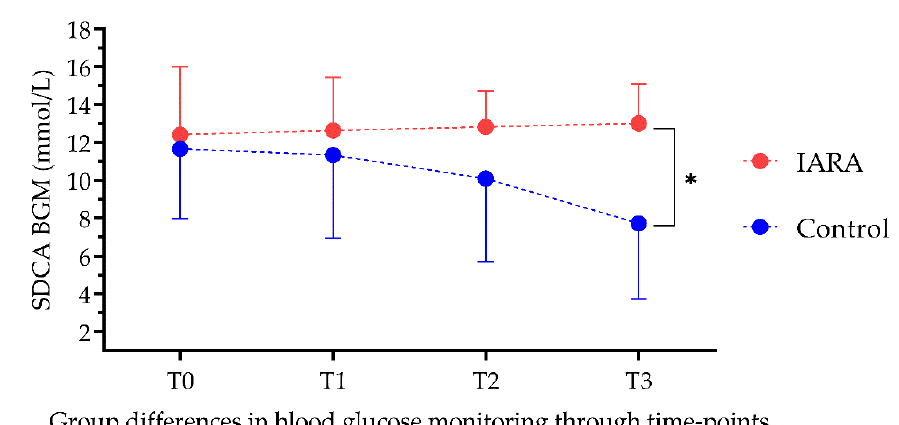
Figure 3. State anxiety was significantly reduced in people who followed the IARA model. STAI- YI — State Anxiety Scale; T0 — baseline; T1 — 3-month follow-up; T2 — 6-month follow-up; T3 — 12- month follow-up; * — p < 0.05.